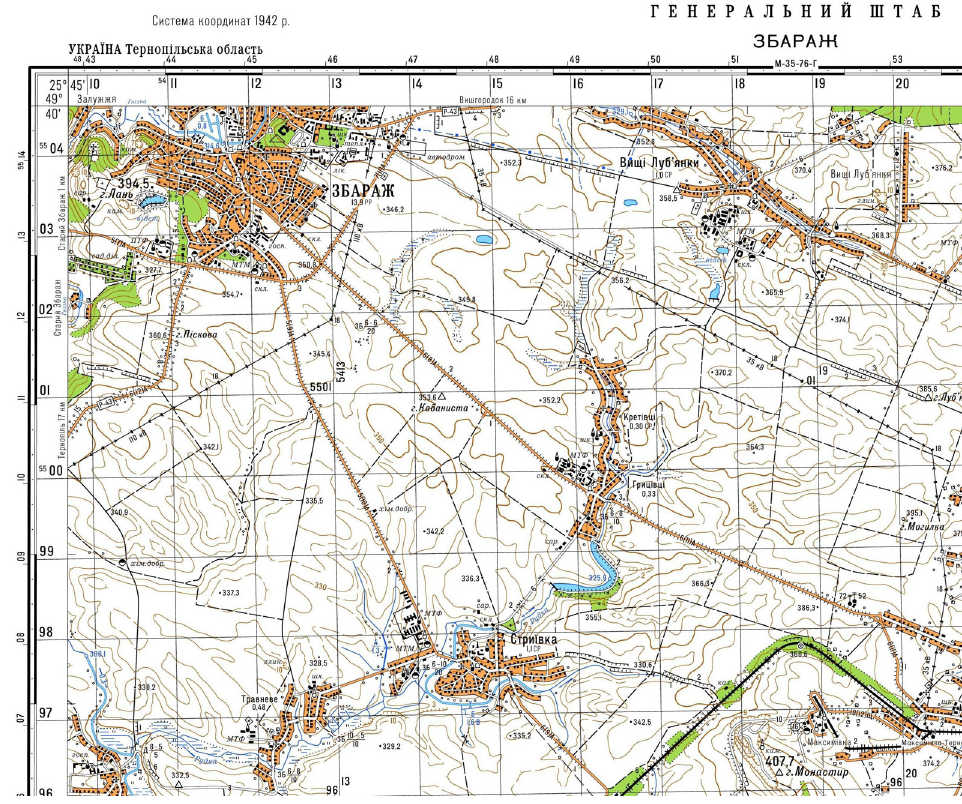
Fig. 5. A part of the traditional 1:50,000 scale topographic map (made according to the instructions for topographic